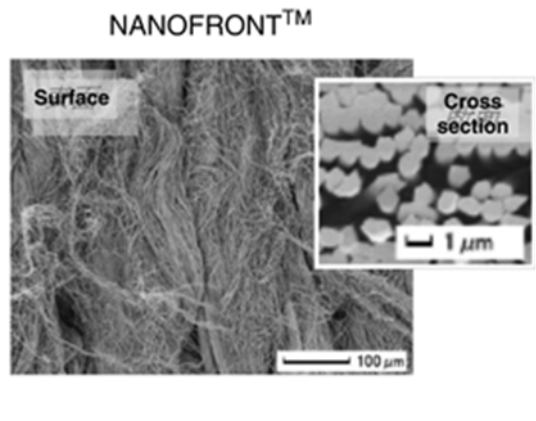
Fig. 15. Nanofiber structures, which can polish and collect dust. Reprinted by permission from Macmillan Publishers Ltd. [87].